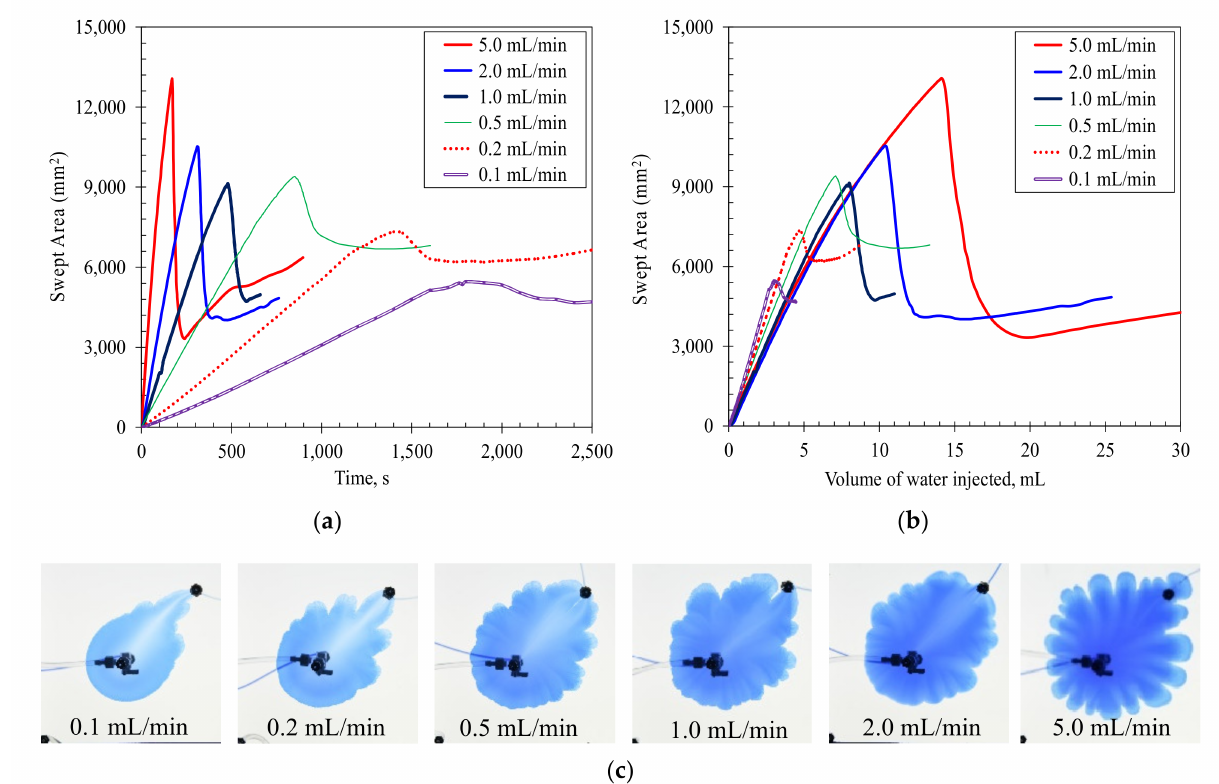
Figure 8. Variations of swept area for different injection rates and volume of water injected. ( a ) Swept area vs. time; ( b ) Swept area vs. volume of water injected; ( c ) The viscous fingering at the maximum swept area for different injection